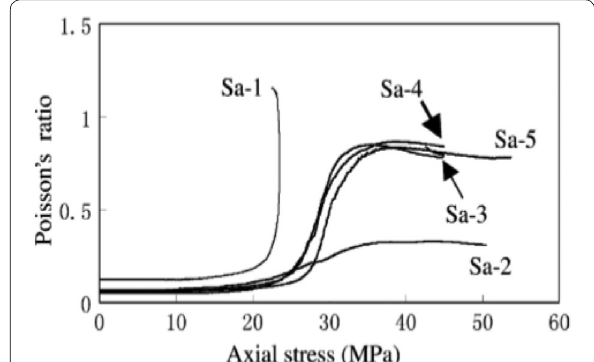
Fig. 8 Relationship of axial stress and Poisson’s Ratio of FRP-confined concrete (Wu et al.